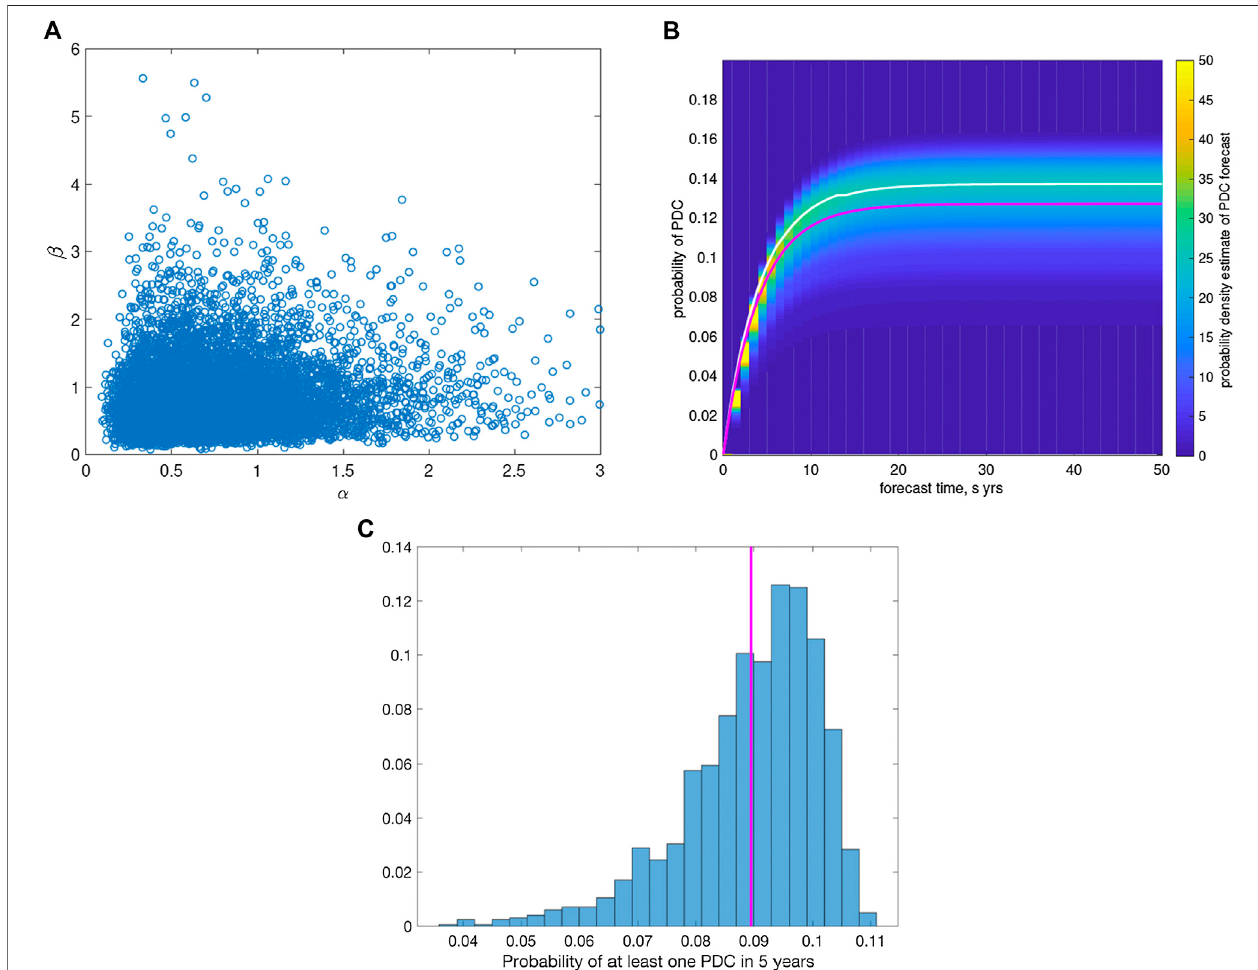
FIGURE 9 | Top Left (A) : a scatter plot of posterior Monte Carlo samples from π ( α , β ) re fl ecting uncertainty in the duration model, i.e., samples from the posterior probability distribution for T (Wolpert et al., 2016). Each sample (plotted point) of ( α , β ) represents a single possible shape for the duration distribution. Top Right (B) : Probabilitydensityfunctionestimates(incolor)of fl owforecastprobabilities(leftaxis)astheyevolveinforecasttime s (bottomaxis).Uncertaintyintheseforecastsre fl ects uncertainty in the duration model. Bottom (C) : Histogram of (normalized) pdf for probability of at least one PDC in next s (cid:2) 5 years, following s (cid:2) 7 years of quiescence — a slice from panel (B) at abscissa s (cid:2) 5. Note left skewness [also visible in (B) ].